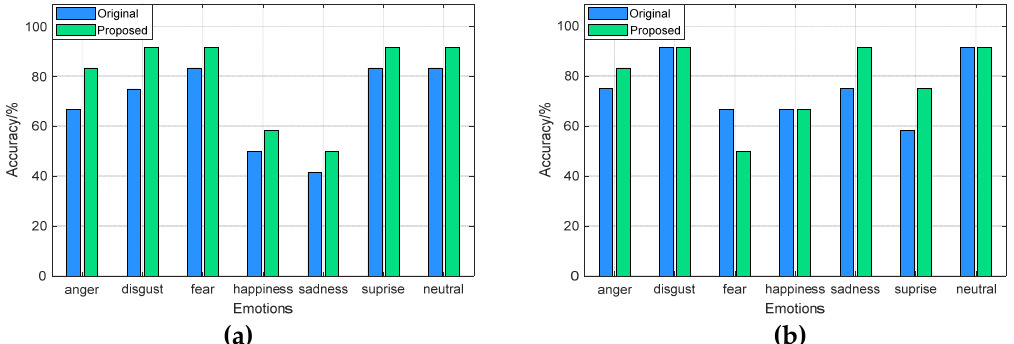
Figure 7. Recognition results on SAVEE: ( a ) SVM classifier; ( b ) RF classifier.